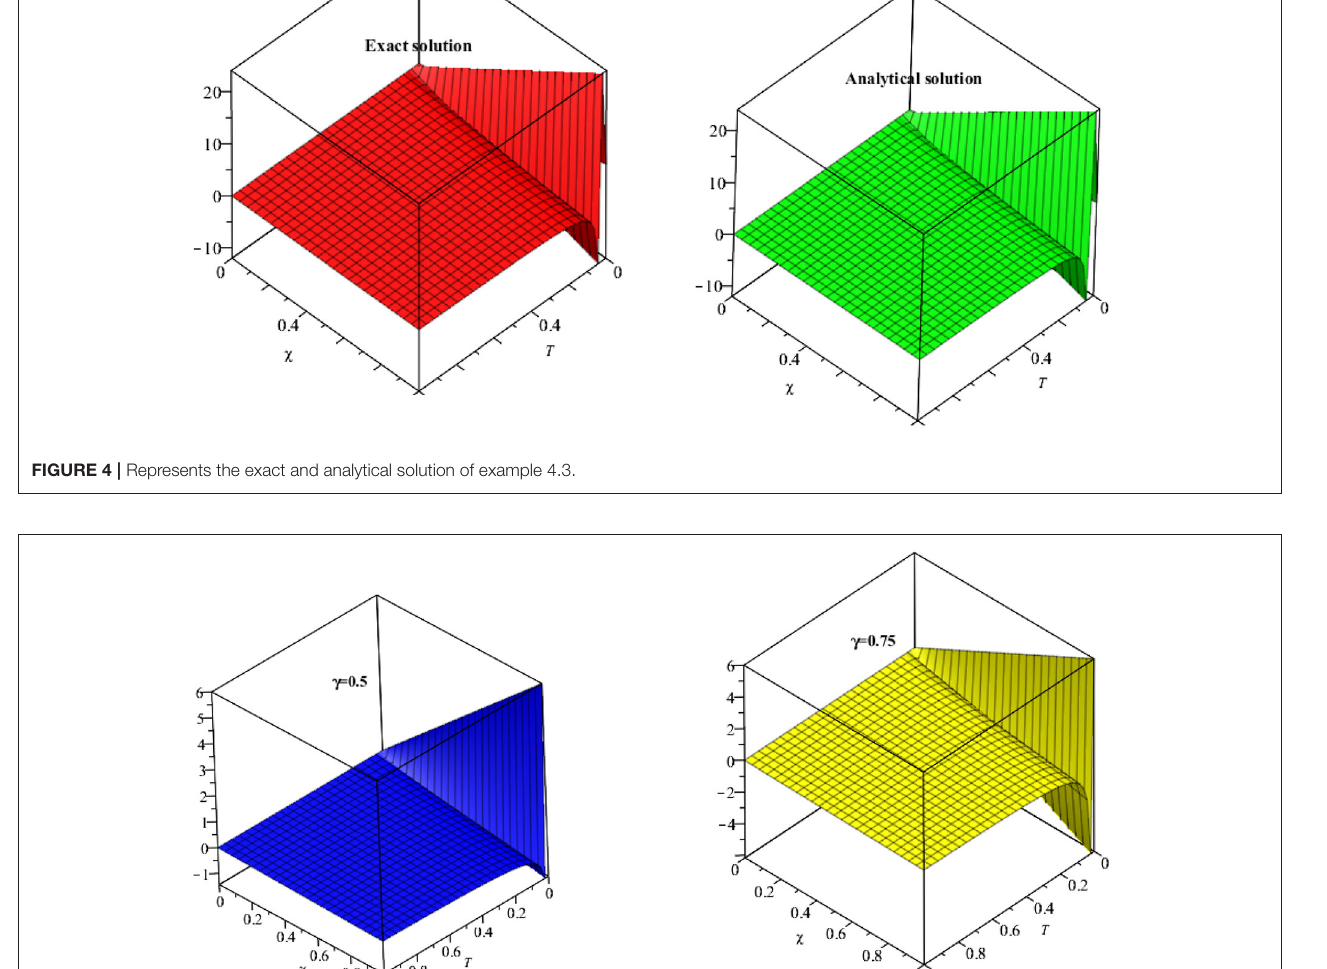
FIGURE 5 | Represents the solution of example 4.3 at γ = 0.75, γ =